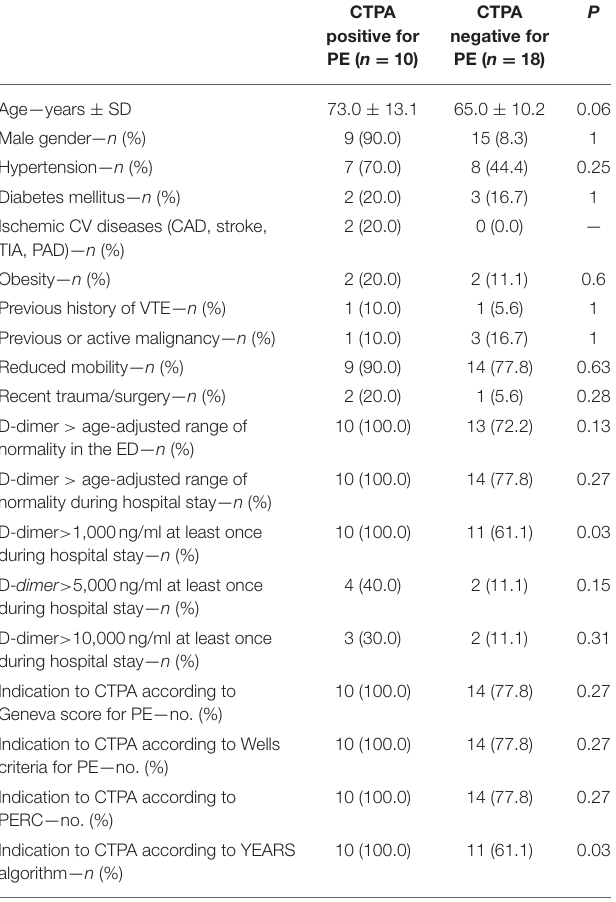
TABLE 2 | Demographical and clinical characteristics of the patients with CTPA positive for PE and of those with CTPA negative for PE.